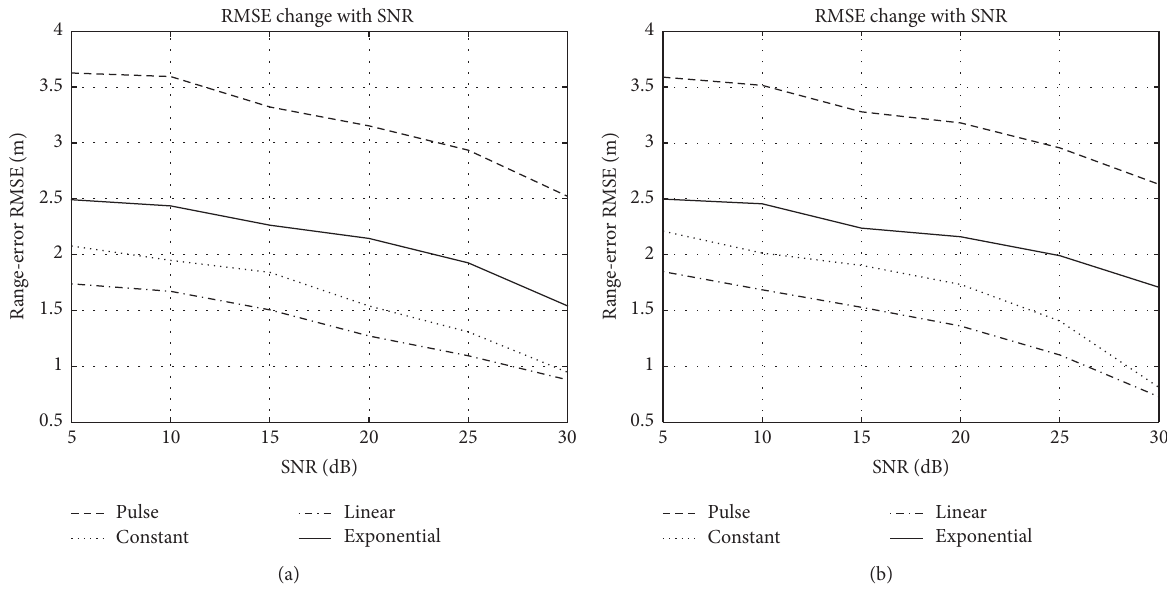
Figure 11: Range-error RMSEs in typical marine target parameters. (a) RMSE versus SNR with V = 4 m/s and 𝑎 = 0 m/s 2 . (b) RMSE versus SNR with 𝑎 = 1 m 2 /s and V = 1 m/s.